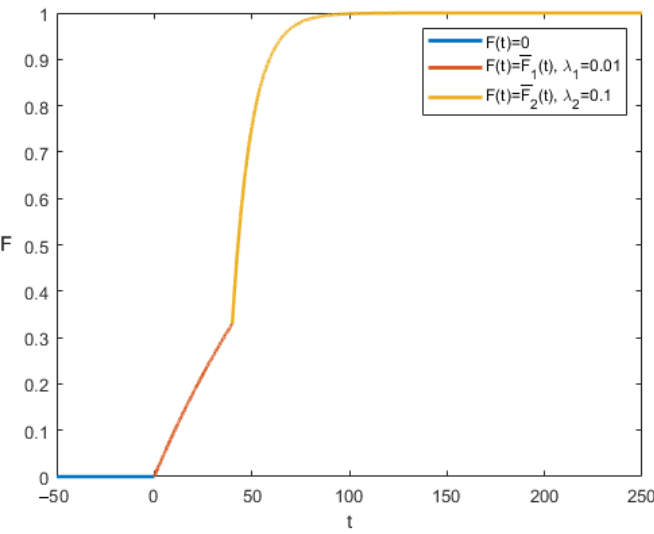
Figure 1. Cumulative distribution function ( λ 1 = 0.01, λ 2 = 0.1, τ 1 =